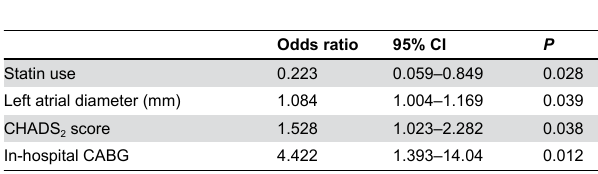
Table 4. Significant multivariate * predictors of new-onset atrial